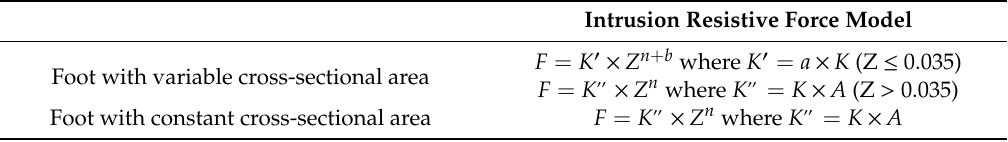
Table 6. Revised intrusion resistive force